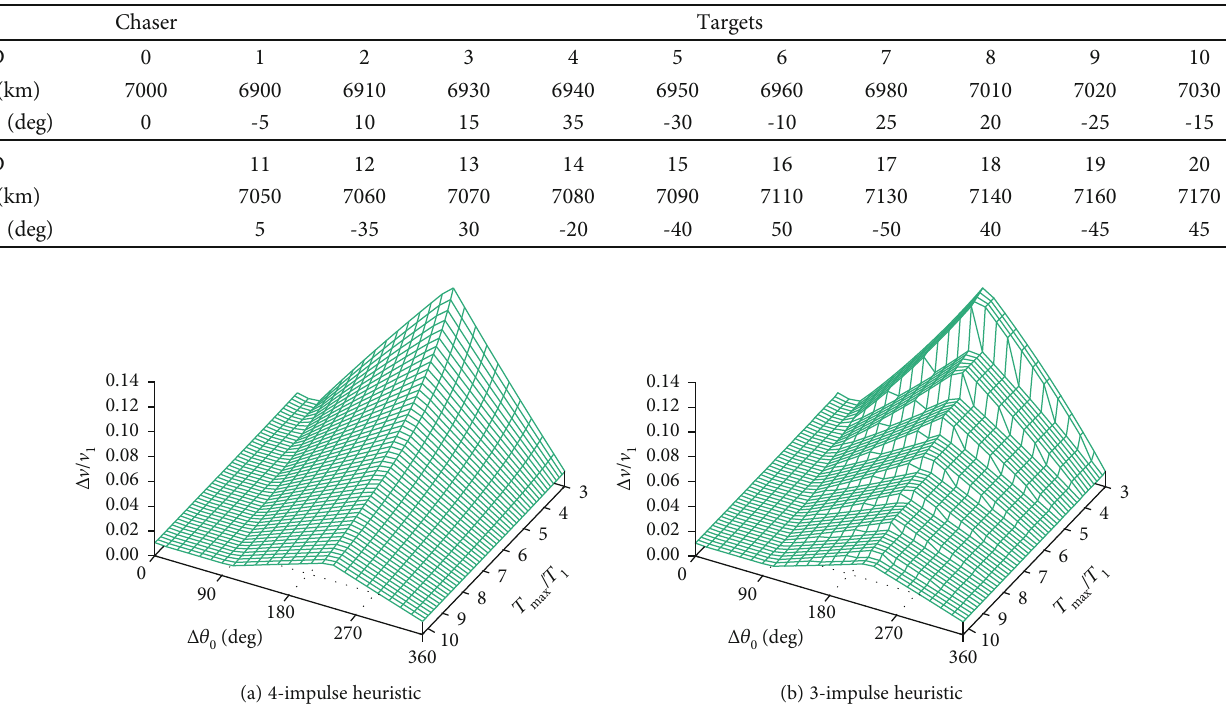
∈ ½ 3 T (cid:2) . Δ V is , 10 T max 1 1